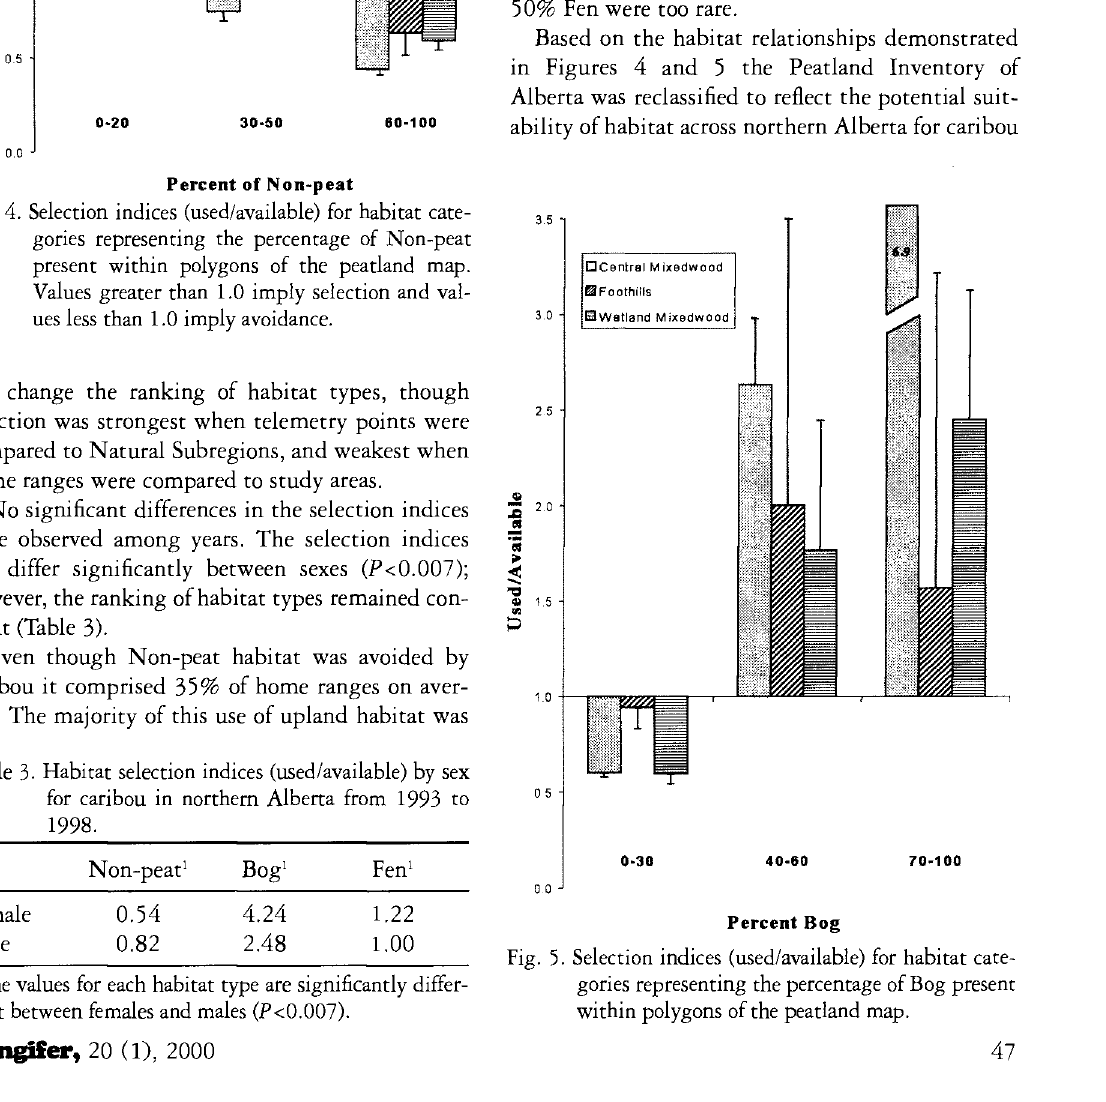
Fig. 5. Selection indices (used/available) for habitat cate gories representing the percentage of Bog present within polygons of the peatland